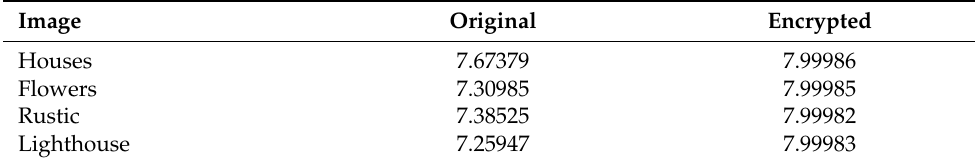
Table 13. Global information entropy for the examined